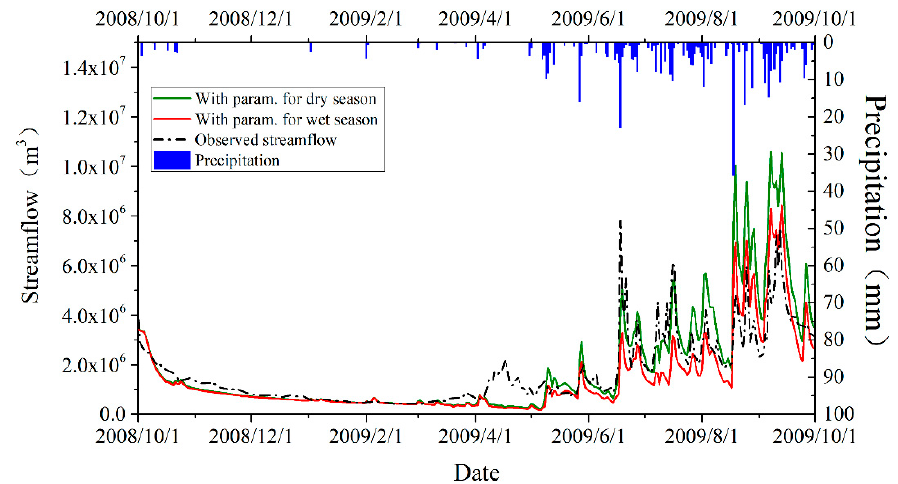
Figure 9. Simulated daily streamflow with applying the parameters calibrated for dry seasons to the entire year and with the parameters calibrated for wet seasons.